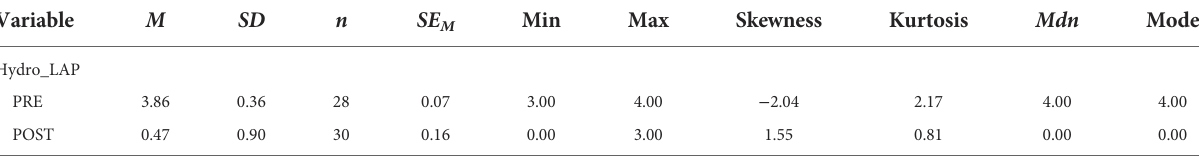
TABLE 4 Summary statistics table for interval and ratio variables by time_hydro_LAP .